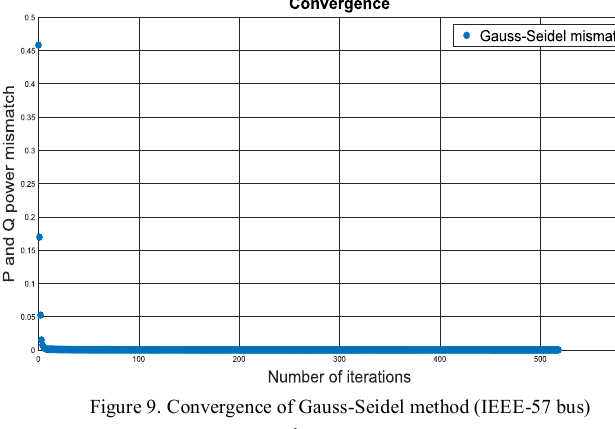
Figure 9. Convergence of Gauss-Seidel method (IEEE-57 bus)